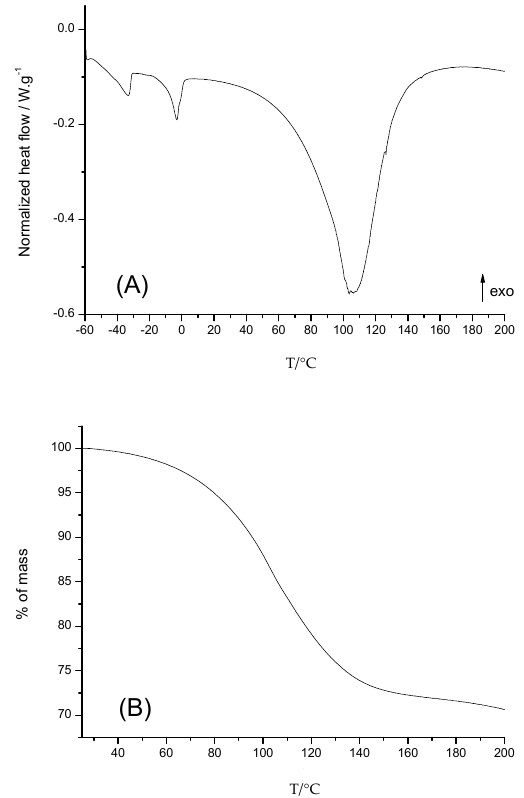
Figure 6. DSC ( A ) and TGA ( B ) curves obtained for the MCT based emulsion prepared with 2% of Zonyl ® .